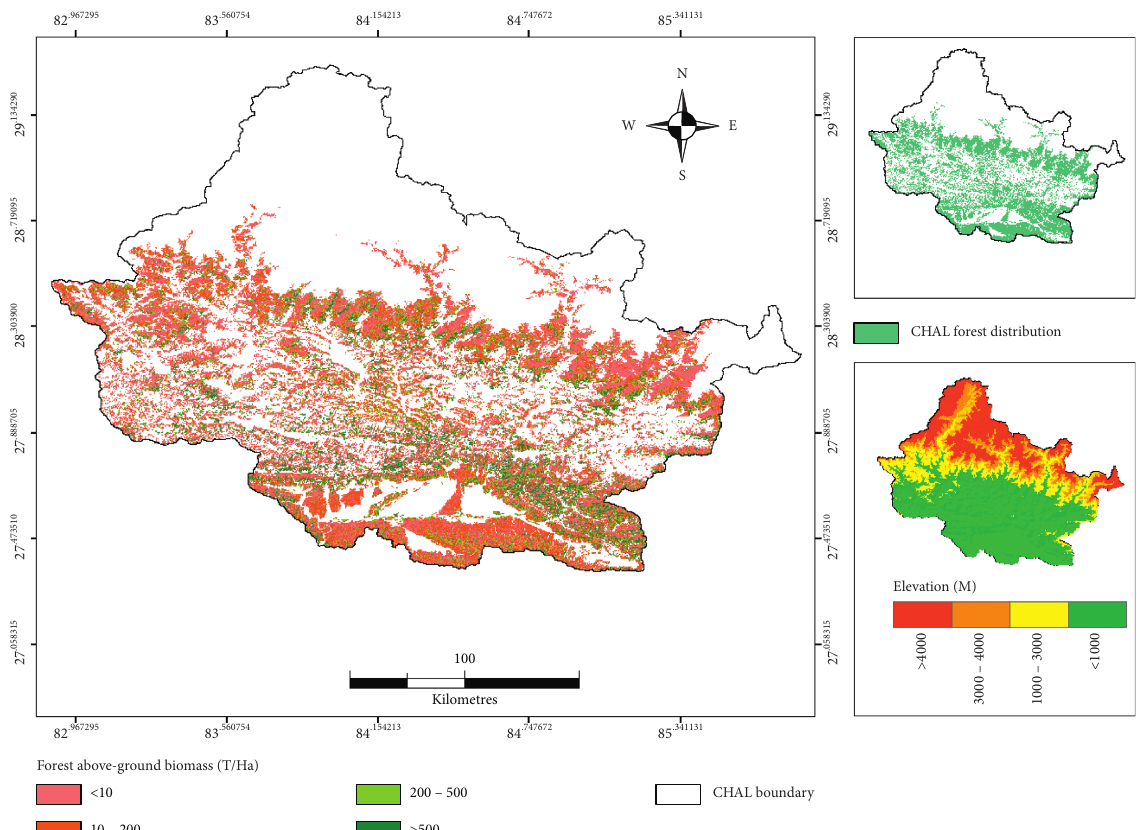
Figure 3: Map showing the spatial distribution of above-ground biomass in the CHAL